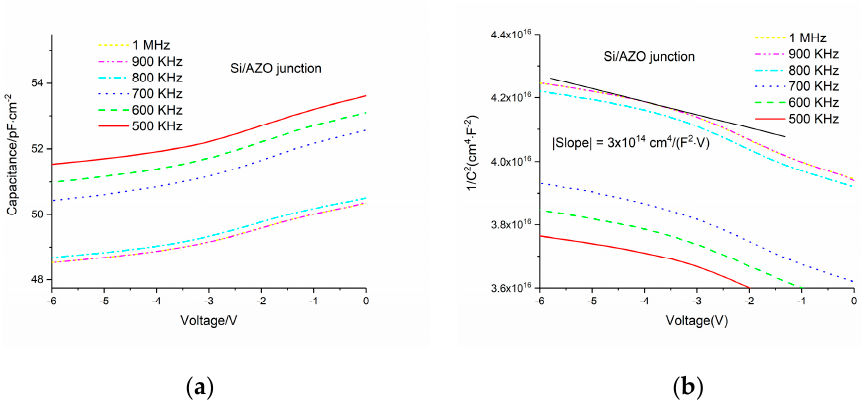
Figure 5. ( a ) Capacitance–voltage measurement data for p-Si/n-AZO junction; ( b ) 1/C 2 –V curve for p-Si/n-AZO junction.